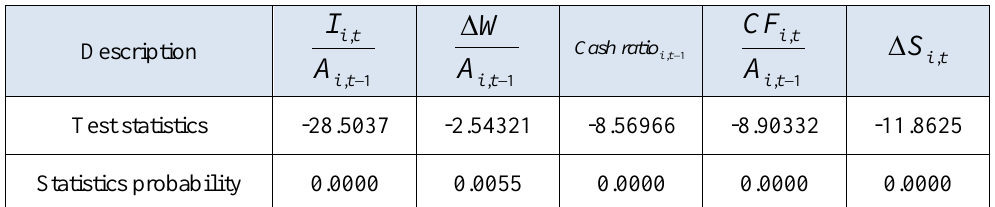
Table 3. Results of the reliability test of research